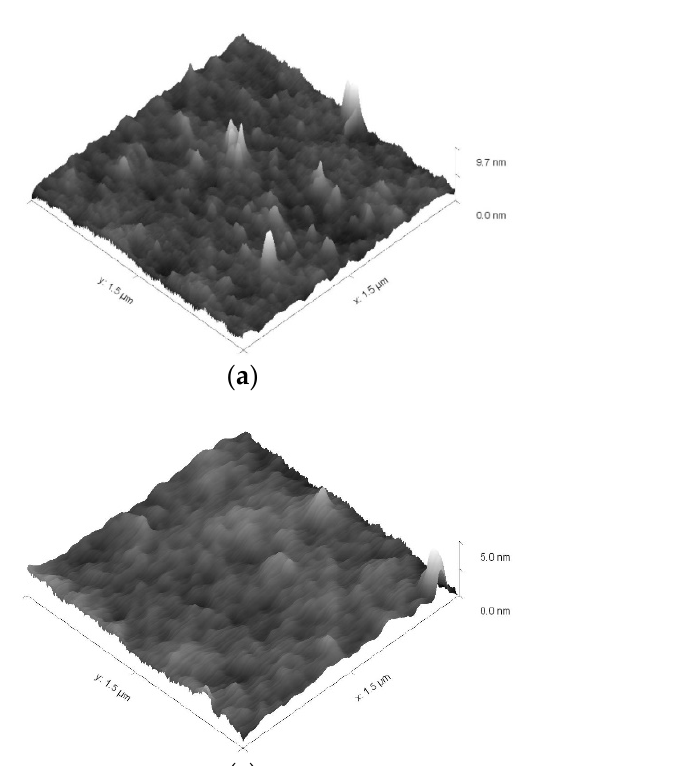
Figure 8. Temperature DLT dependences of polymers modified by the ASiP–AGM-10 ( a ) and the ASiP–AGM-50 ( b ) with their content: 0.0 (1), 0.05 (2), 0.10 (3), 0.20 (4) and 0.30 (5) wt.%.